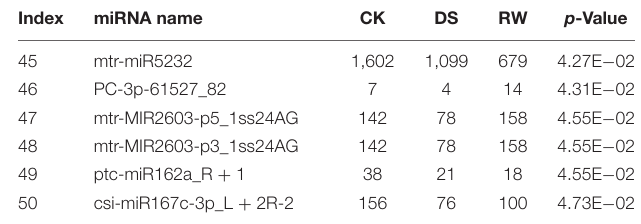
TABLE 6 | The small RNA sequencing results of 50 DEMs in the CK, DS, and RW